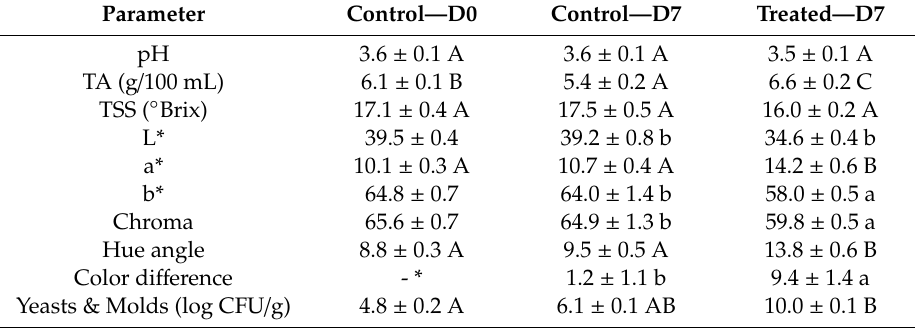
Table 6. Physicochemical parameters and population of yeast and molds for control and treated samples during storage at 4 ◦ C. D0 correspond to freshly prepared pineapple and D7 to samples after 7 days of storage. Di ff erent uppercase letters in the same line indicate significant di ff erences. Lower case letters indicate di ff erences according to bilateral Dunnet’s test. *: not